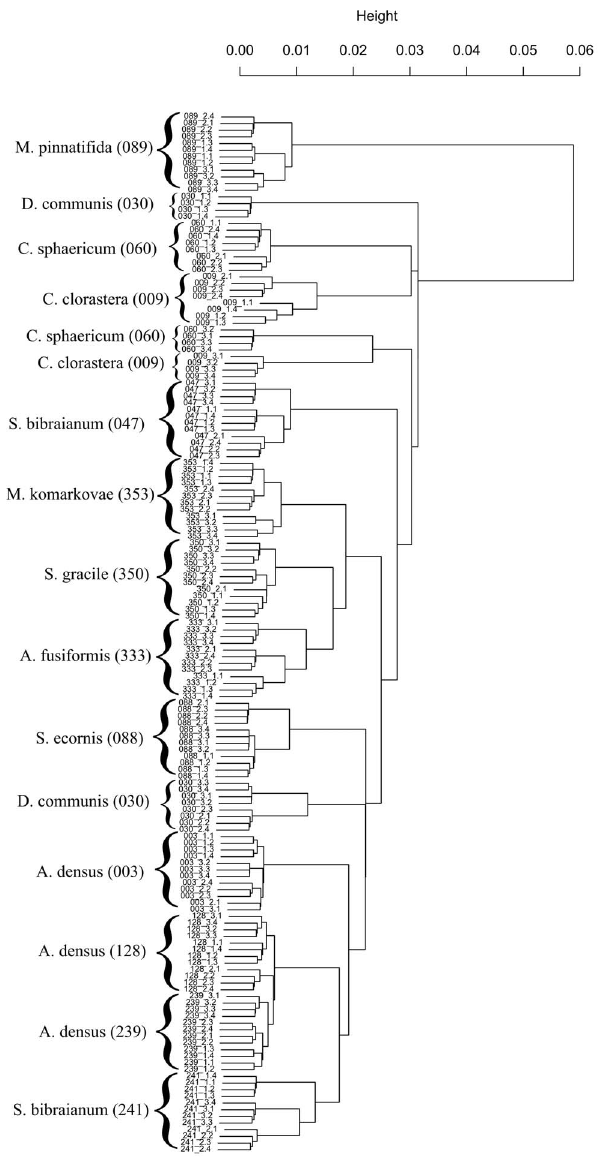
Fig. 6. Dendrogram generated by hierarchical cluster analysis (HCA) of the strains, based on data from windows IV and V of the 9-point first derivative spectra (containing the carbohydrate window - 1200– 675 cm 2 1 ). 1000 replicate bootstrap values are shown, except for nodes discriminating film replicates. Strains of microalgae: Ankistrodesmus densus (003), Chlamydomonas clorastera (009), Desmodesmus communis (Hegewald) Hegewald 2000 (030), Selenastrum bibraianum (047), Coelastrum cf sphaericum (060), Scenedesmus ecornis (088), Micrasterias pinnatifida (089), Ankistrodesmus densus (128), Ankistrodesmus densus (239), Selenastrum bibraianum (241), Ankistrodesmus fusiformis (333), Selenastrum gracile (350) and Monoraphidium komarkovae (353).